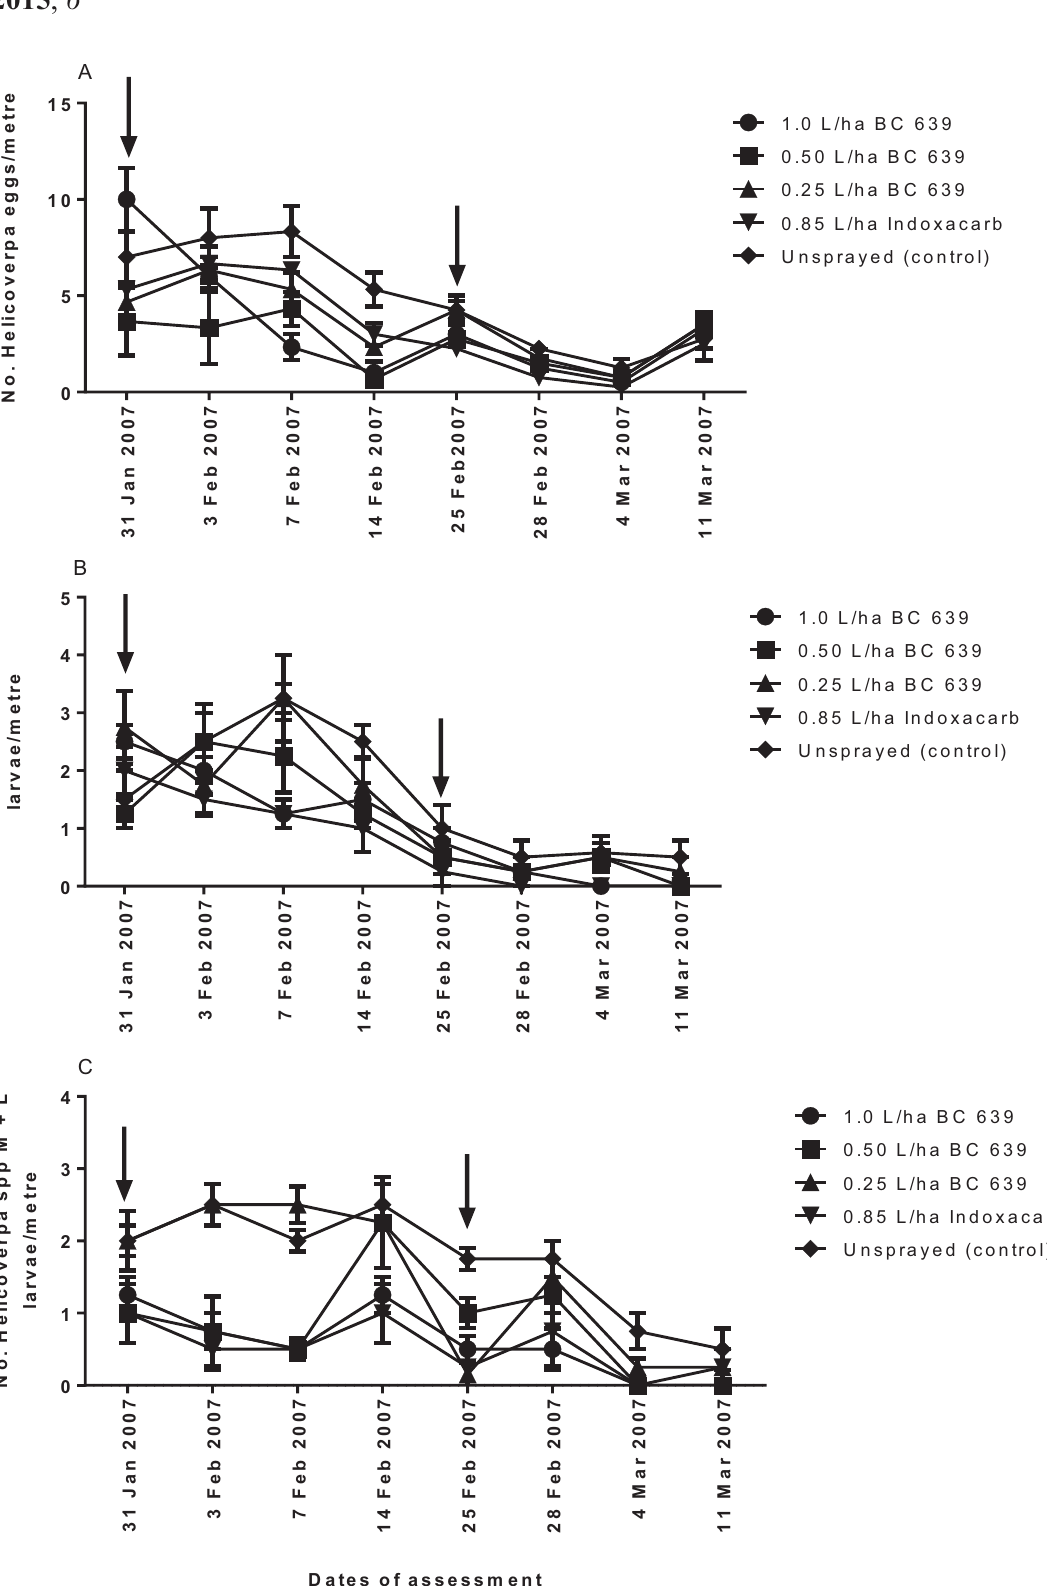
Figure 2. The efficacies of different rates of application of BC 639 and Indoxacarb in reducing numbers of Helicoverpa spp. ( A ) eggs, ( B ) very small + small (VS + S) larvae ( i.e ., instars 1 – 3) and ( C ) medium + large (M + L) larvae ( i.e. , instars 4 – 6) per metre on commercial conventional cotton crops at Getta Getta near Goondiwindi, 2006 – 2007. The arrows indicate the date of